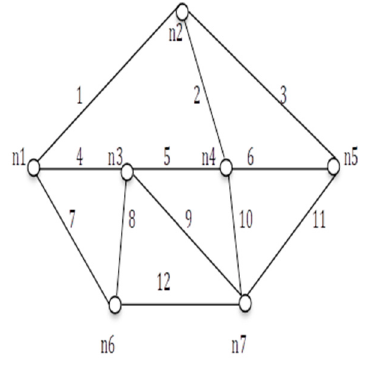
Figure 12. G (8, 11). Sensors 2020 , 20 , x FOR PEER REVIEW Figure 13. G (7, 14).